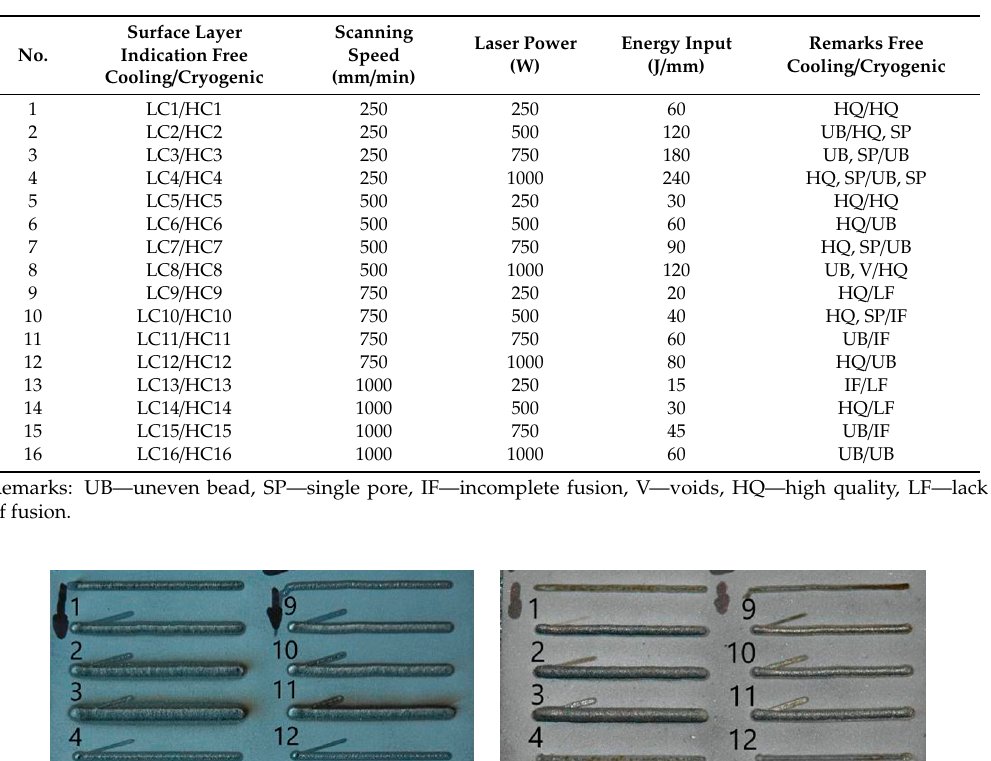
Table 3. Parameters of laser deposition of experimental Fe-based metallic powder at free cooling conditions (conventional laser cladding) and forced cooling by liquid nitrogen bath under cryogenic conditions (hybrid laser deposition process), as shown in Figure 3. No. Surface Layer Indication Free Cooling/Cryogenic